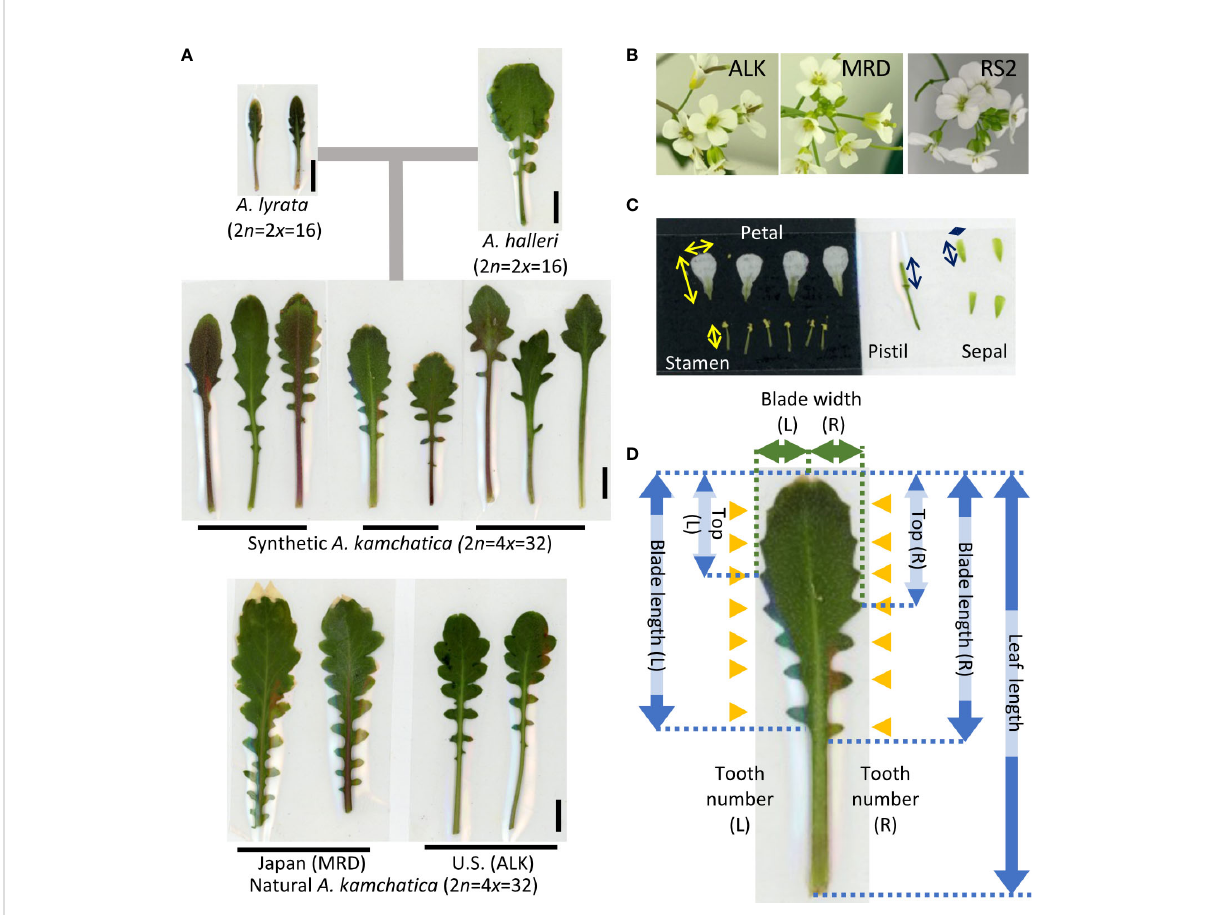
FIGURE 1 Representative leaf and fl ower shape of A. kamchatica and the traits used for the analysis. (A) Representative leaves of diploid progenitors, and synthetic and natural A. kamchatica genotypes grown in the chamber. The horizontal lines suggest the leaves collected from the same individual. The vertical lines indicate 1 cm. (B) Representative fl owers of A. kamchatica , ALK, MRD and RS2. (C) An example of pressed fl oral organs. The arrows indicate the measured positions of each organ, vertical (length) and horizontal (width). (D) The positions of measured traits on leaf morphology. The arrows indicate the length or width of each trait, and the orange triangles indicate the position of leaf tooth on R (right) and L (left) sides,